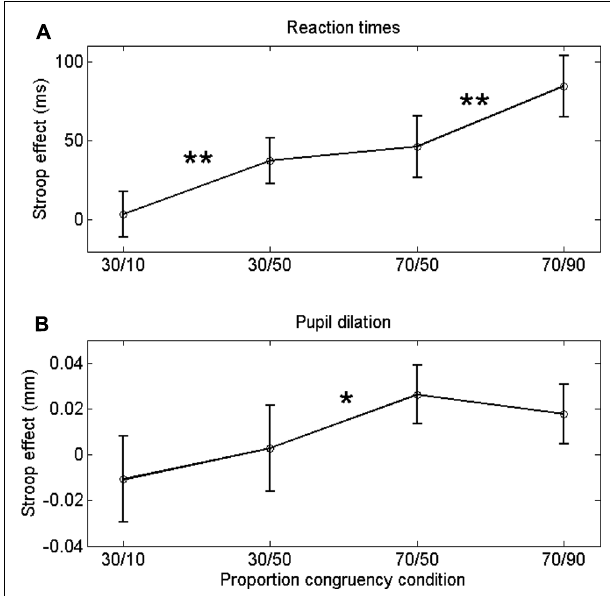
FIGURE 2 | Congruency (Stroop) effect on RT (A) a and pupil dilation (B) for each list-level/item-specific proportion congruency. Asterisks indicate significant differences: ** p < 0.01; * p < 0.05. Error bars are based on within-subjects error (Masson and Loftus,